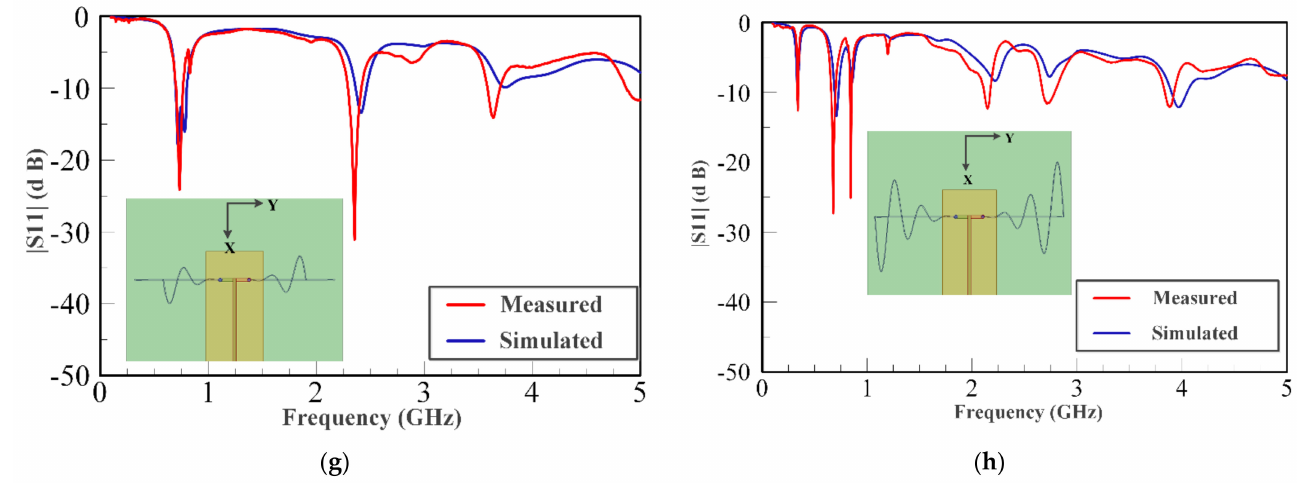
Figure 5. Measured and simulated S-parameter values (|S 11 | (dB)) for different scenarios. ( a ) t 1 = 0.8 in. and t 2 = 0.8 in. ( b ) t 1 = 1.6 in. and t 2 = 0.8 in. ( c ) t 1 = 1.6 in. and t 2 = 1.6 in. ( d ) t 1 = 2.4 in. and t 2 = 1.6 in. ( e ) t 1 = 1.6 in. and t 2 = 2.4 in. ( f )